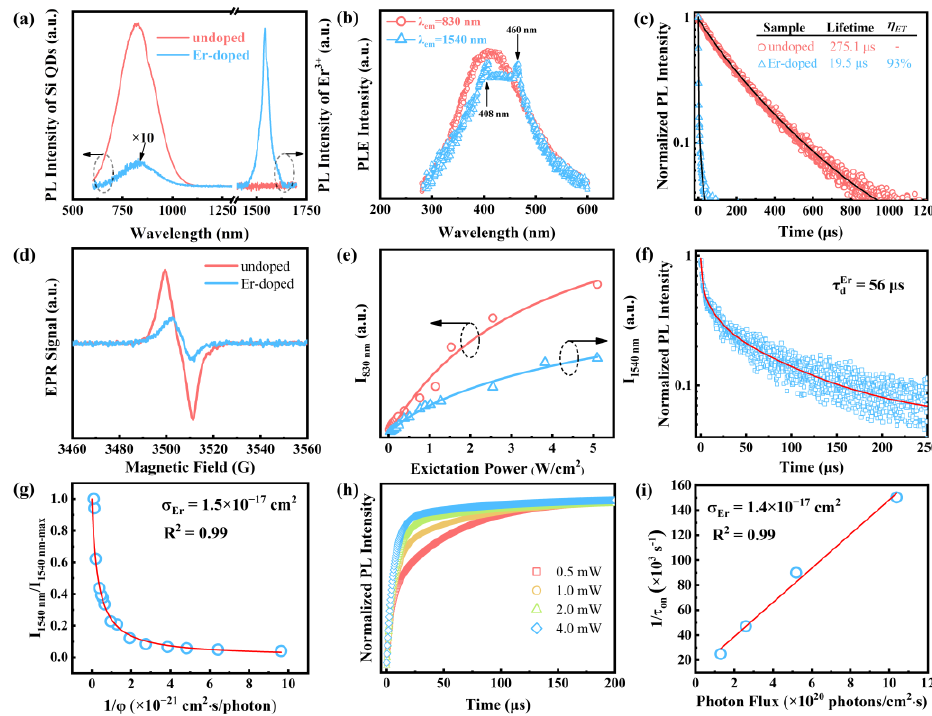
Figure 4. ( a ) NIR PL emission of Si QDs, pristine and with Er hyperdoping. ( b ) PLE spectra of Si QDs with Er hyperdoping. ( c ) The 830 nm PL decay curves of Si QDs, pristine and with Er hyperdoping. λ ex = 405 nm. ( d ) First-derivative EPR spectra. ( e ) PL intensity detected at different excitation power, measured at 830 or 1540 nm. λ ex = 405 nm. ( f ) PL decay monitored at 1540 nm ( λ ex = 405 nm) and the fitted curve. ( g ) The dependence of integrated PL intensity of the Er-related luminescence (1540 nm) on the reciprocal of photon flux. A line fitting the data is also shown. ( h ) Transient PL intensity at 1540 nm, normalized to the maximum value. ( i ) Photon-flux-dependent reciprocal of τ on .